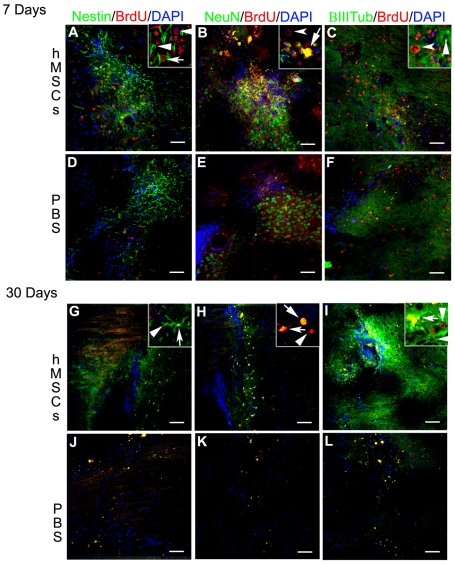
hMSC implantation recruited neuronal cells and induced neurogenesis.There was a slight increase in Nestin + NPCs to the site of the graft (A) compared to the PBS injection (D) at 7 days post-implantation. Many of these recruited Nestin+ NPCs remained proximal to the graft until 30 days (G compared to J). There was also an influx of NeuN+ neurons (B) and, to a lesser extent, βIII tubulin + neurons (C) to the hMSC graft compared to the PBS injection (E,F) at 7 days. At 30 days post-implantation there were still more NeuN+ (H) neurons and an overwhelming increase in the number of βIII tubulin + (I) neurons at the site of the graft compared to the PBS-injected, contralateral hemisphere (K,L). Some BrdU+ cells co-labeled with Nestin at 7 days (inset image A) and 30 days (inset image G) post-implantation. A few BrdU+ cells were NeuN+ at 7 days post-implantation (inset image B). This number had increased by 30 days post-implantation (inset image H). No BrdU+ cells had matured into βIII tubulin+ neurons at 7 days post-transplantation (inset image C). By 30 days, many BrdU+ cells did co-express βIII tubulin (inset image I). Squares demarcate location of high magnification inset. Scale bar = 50 µm. Arrows = co-labeled cells, arrowheads = single labeled cells.